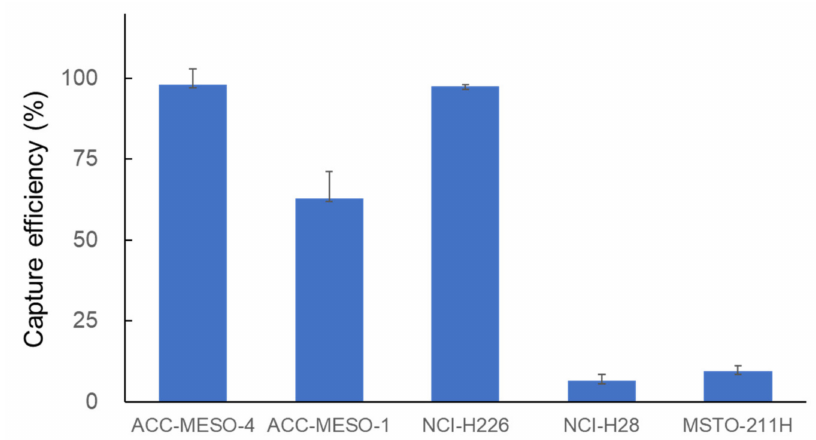
Figure 3. Cell-capture e ffi ciency of the CTC-chip coated with an anti-podoplanin antibody (NZ-1.2) at the concentration of 5 mg / mL in capturing various malignant pleural mesothelioma (MPM) cells (ACC-MESO-1, NCI-H226, NCI-H28, and MSTO-211H).